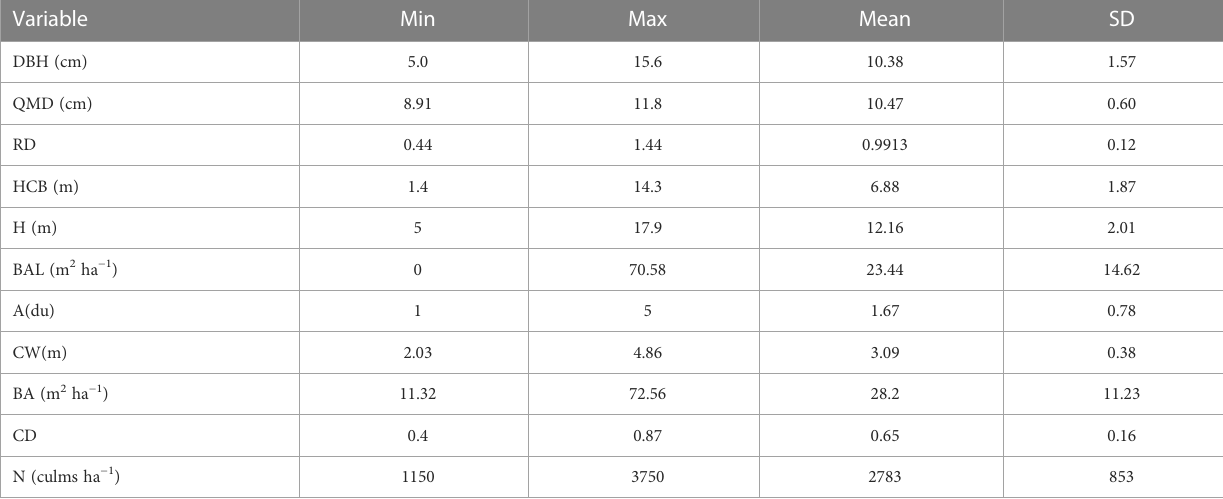
TABLE 1 Bamboo forest variables